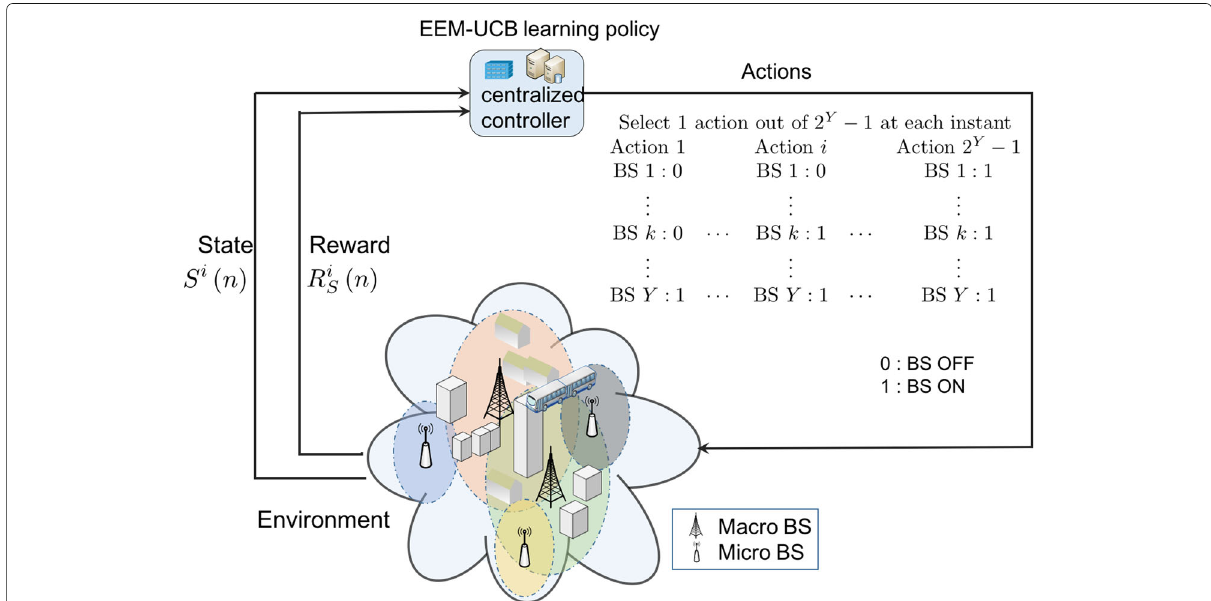
Fig. 1 Reinforcement learning (RL) framework for BS switching operation. The figure illustrates the principle of the multi-armed bandit reinforcement learning model for ON/OFF base